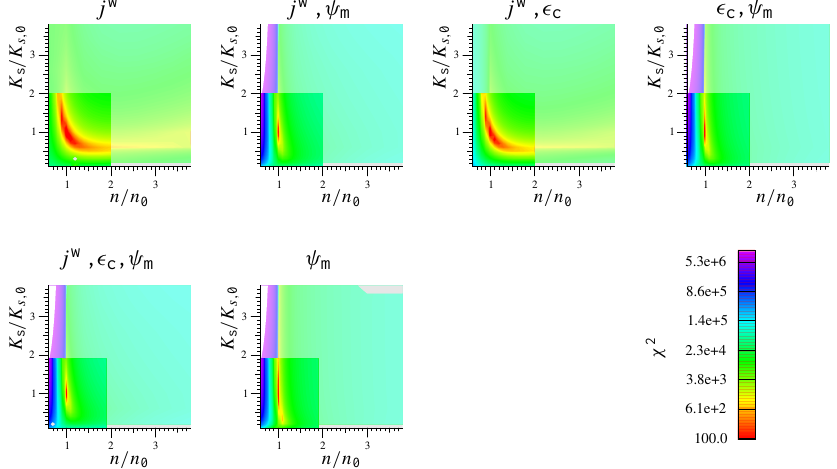
Fig. 13. Same as Fig. 12 but with different target variable combinations. Note that real permittivity measurements have large errors in the dry range, which would lead to much worse results for the case (cid:15) c + ψ m